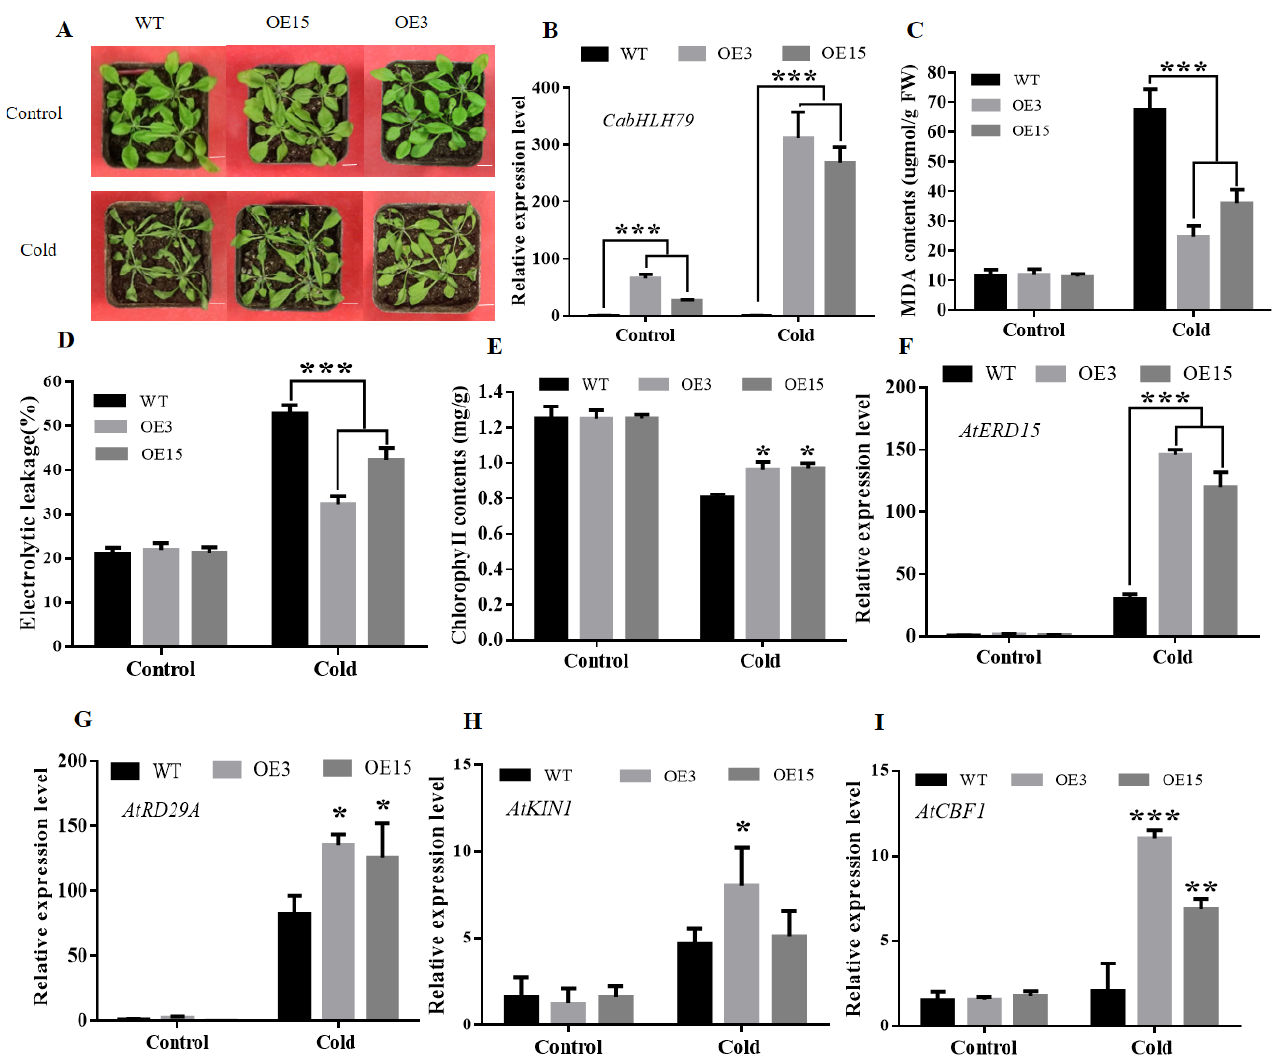
Figure 6. Overexpression of CabHLH79 in Arabidopsis improves tolerance to low temperature stress. ( A ) The phenotype of CabHLH79 overexpression and WT line under cold stress. The white line is used as a scale bar (length 1 cm). ( B ) Transcriptional levels of CabHLH79 under cold stress. ( C – E ) MDA, REL, and Chlorophyll contents. ( F – I ) RT-qPCR analysis of AtERD15 , AtRD29A, AtKIN1, and AtCBF1. All data of three independent biological replicates were expressed by Means ± SDs. * representing significant difference (* p < 0.05, ** p < 0.01, *** p < 0.001).